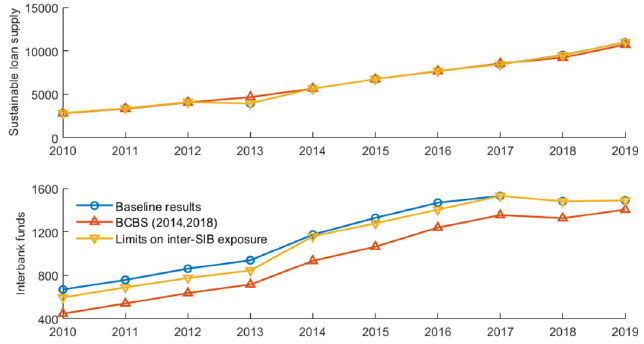
Fig 12. The sustainable loan supply and interbank funds with limits on interbank